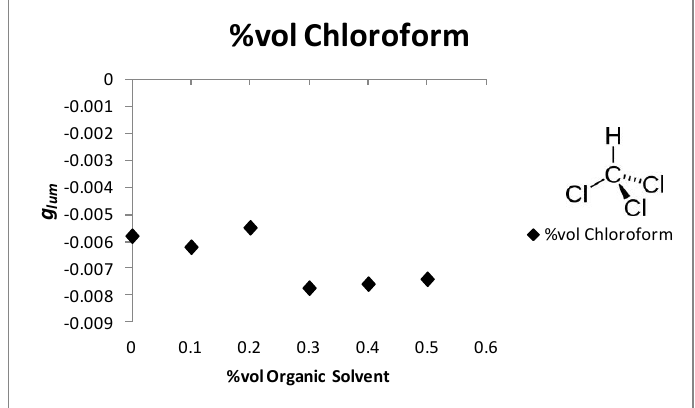
Figure 10. Plots of luminescence dissymmetry values ( g lum ) of [Tb(DPA) 3 ] 3− Conditions: 0.005 M [Tb(DPA) 3 ] 3− with 40 equiv. L -serine. Ratios of 90:10–50:50 H 2 O:chloroform, monitored at the spectral range of 5 D 4 → 7 F 5 at room temperature and pH 7.00, and measured at λ ex = 283.00–289.00 nm and λ em = 542.8.0–543.00 nm.